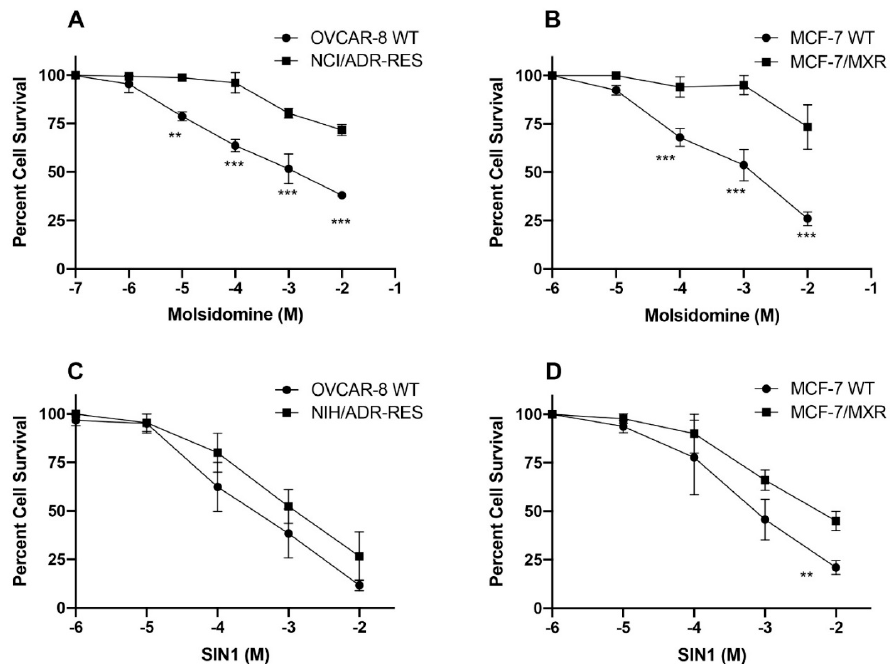
Figure 2. Cytotoxicity of MS in ( A ) WT OVCAR-8 and NIH/ADR-RES Cells; and ( B ) WT MCF-7 and MXR cells. Cytotoxicity of SIN-1 in ( C ) WT OVCAR-8 and NIH-RES/ADR Cells; and ( D ) WT MCF-7 and MXR cells. **, *** p values < 0.005, < 0.001 compared to concentration-matched